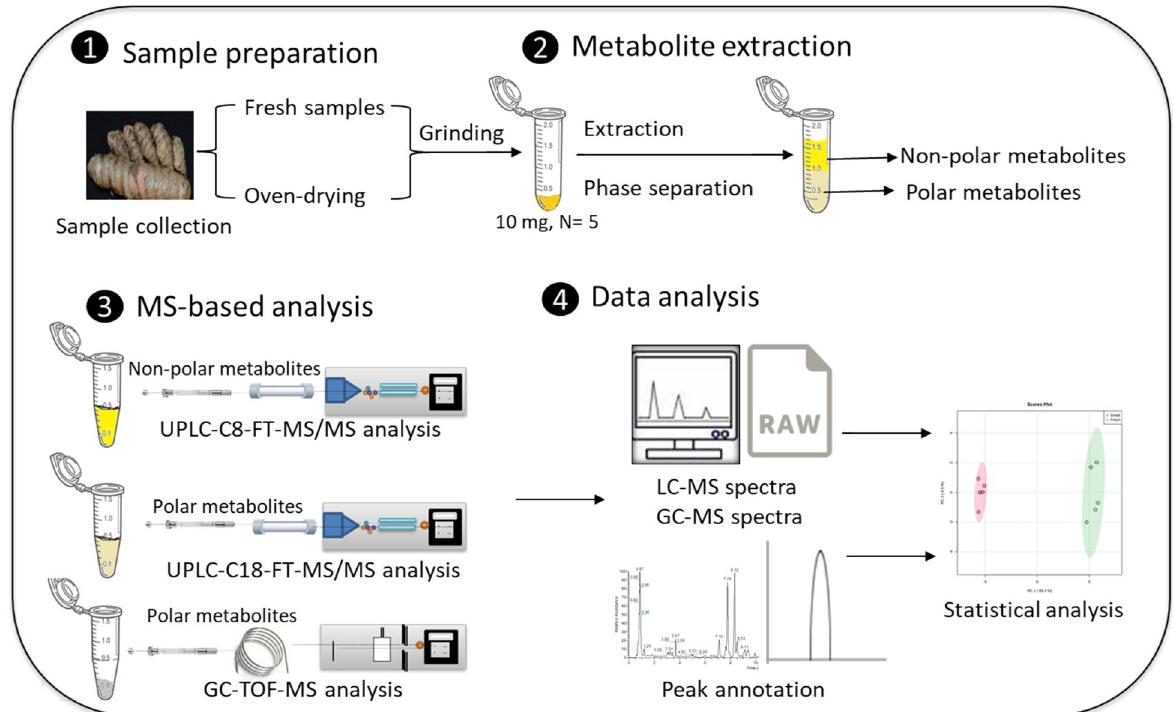
Figure 1. A schematic diagram summarizes the sample preparation, extraction and MS-based analysis of fresh and dried turmeric